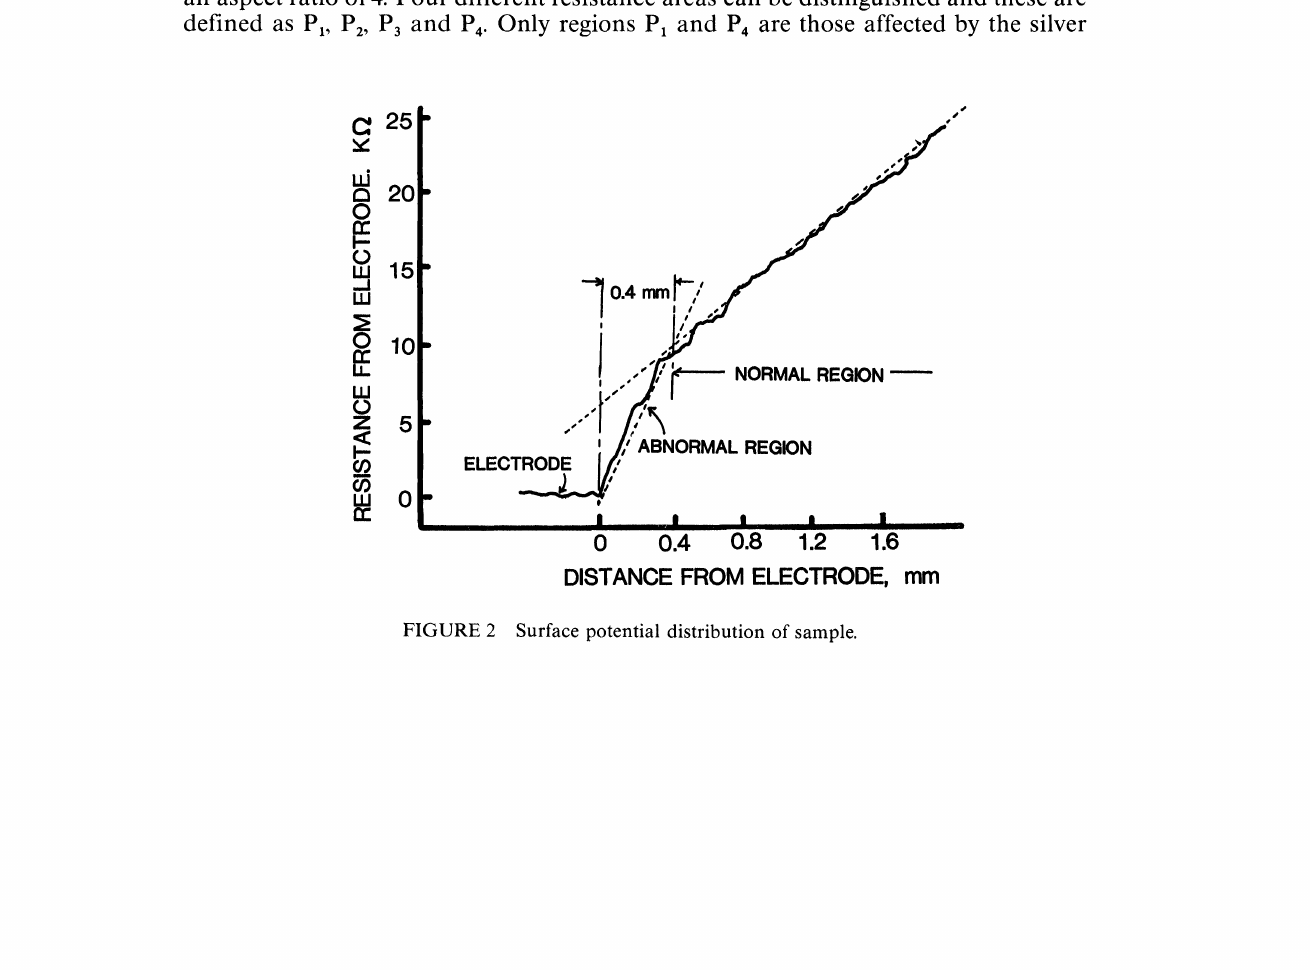
FIGURE 2 Surface potential distribution of